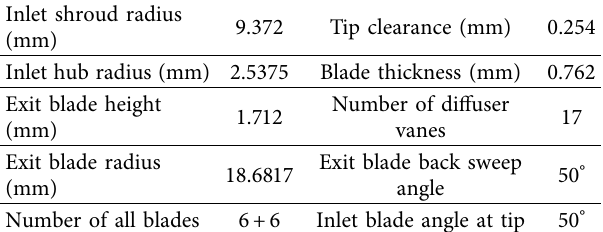
Figure 10: Static pressure ratio at the impeller outlet. Table 1: Design specification of the SNL compressor [30, 31].